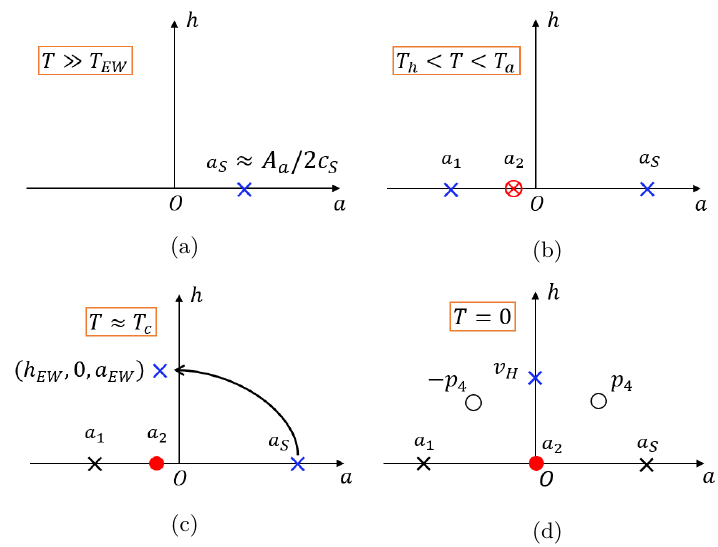
Figure 4. Patterns of symmetry breaking at different temperatures on the a − h plane with h s i = 0 . We use × to denote a minimum, ⊗ to denote a saddle point, • to denote a maximum, and × ( ) to denote a stationary point that may be minimum (maximum). (a) T (cid:29) T : the dark Yukawa # EW coupling breaks the Z symmetry and induces a non-zero vev for the a field at temperatures much 2 higher than T 140 GeV . (b) Below T , the temperature where two additional solutions for the EW ≈ a vev of the a field arise, there are three branches along the direction h = 0 , two of which are minima and one is a saddle point, with the global minimum being (0 , 0 , a ) . When the temperature drops to S T h , a new minimum ( h EW ,0, a EW ) starts to develop from (0 , 0 , a 2 ) . (c) At the critical temperature, the new minimum ( h ,0, a ) becomes degenerate with (0 , 0 , a ) . a has transformed into a EW EW S 2 maximum at this temperature. a could be a minimum or saddle point depending on the relation 1 between the temperature and the model parameters. (d) At T = 0 , ( v 0 , 0) becomes the global H , minimum and the origin becomes a maximum. There are other potential minima or maxima given by eq. (3.11): a , a and a in the plot are the values for the singlet vev at the three stationary 2 1 S points p and ∓ p respectively. Note that we use − p to denote the negative 3 2 i